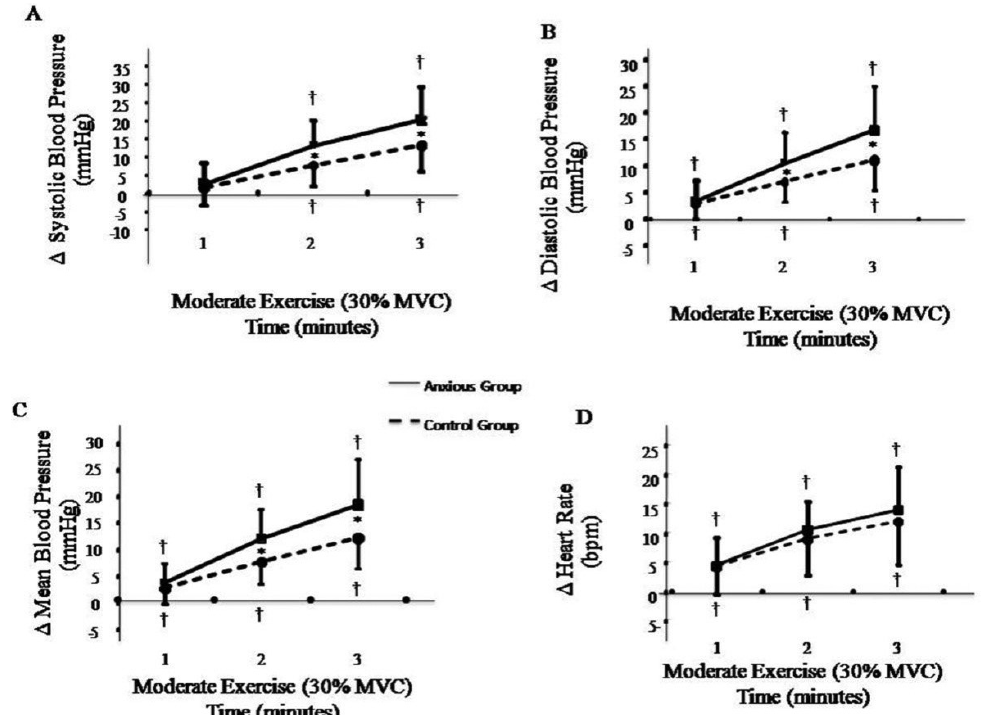
Figure 1. Absolute delta values of the systolic, diastolic, and mean blood pressure (mmHg) and heart rate (bpm) responses during moderate exercise at 30% of maximal voluntary contraction (panels A, B, C, and D, respectively). Note that there were increases in systolic, diastolic, and mean blood pressure and heart rate levels in both groups when compared with the resting condition during moderate exercise, but the pressure elevation levels were higher in the anxious group than in the control group (panels A, B, and C, respectively). The heart rate increased similarly in both groups. Ip≤0.05 vs. baseline; *p≤0.05 vs. group.